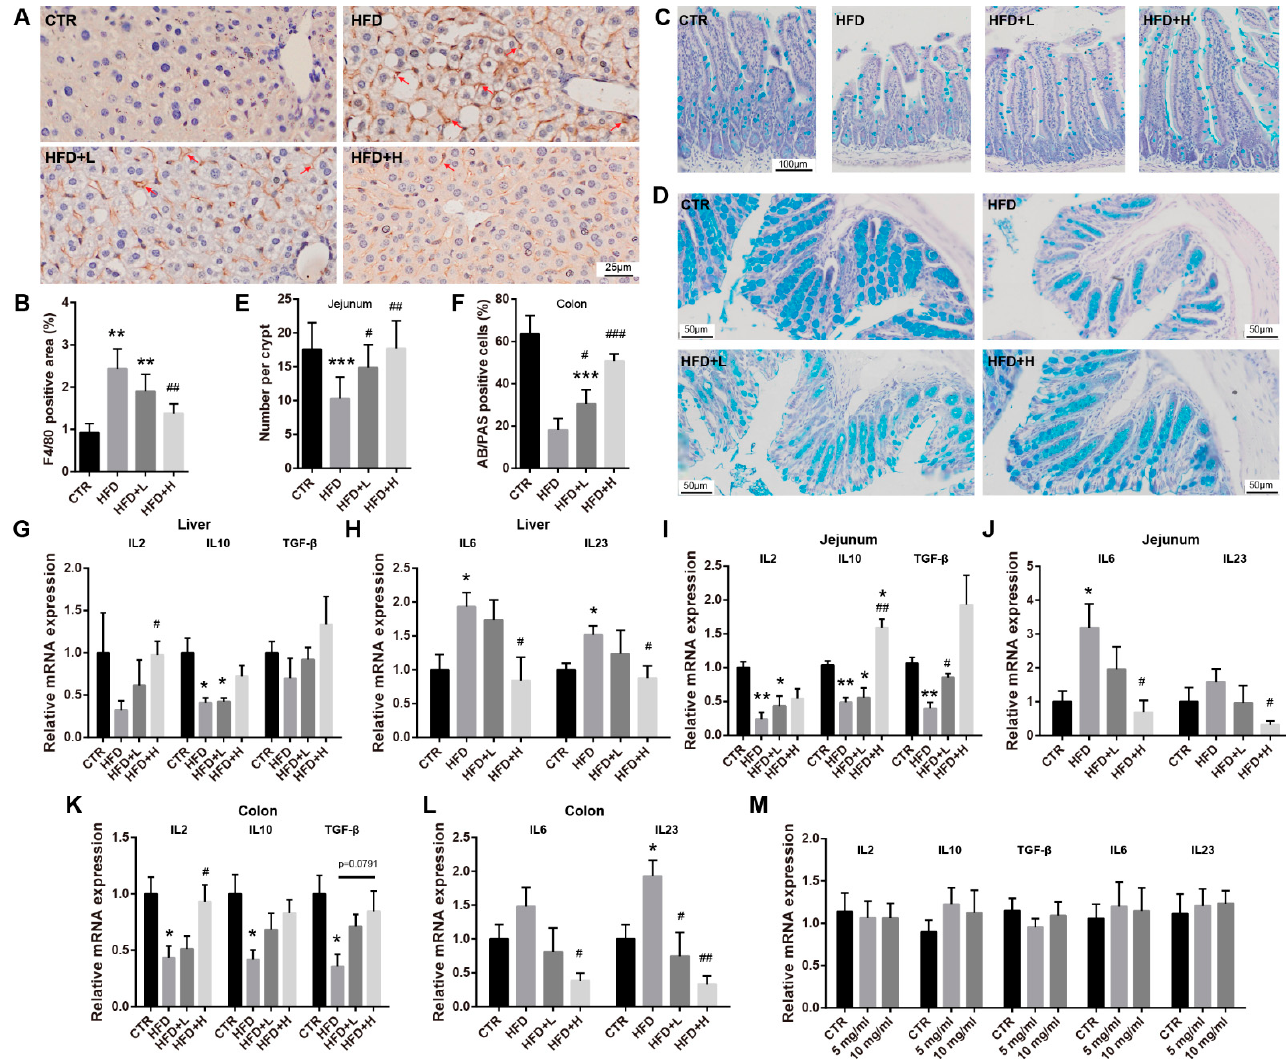
Figure 5. SMRR polysaccharide ameliorates inflammation in gut–liver axis induced by high-fat diet. ( A , B ) Representative images and quantification of F4/80 labeling in liver of each group of mice. Error bars indicate SEM; n = 4; ** or ## p < 0.0 by one-way ANOVA. Arrows indicate F4/80 positive signals; “*” stands for CTR vs. HFD, “#” stands for HFD vs. HFD+H. ( C – F ) Representative images of AB-PAS staining and quantifications showing goblet cells in jejunum ( C ) and colon ( D ) of mice from different groups. Error bars indicate SD; n = 5; * or # p < 0.05, ## p < 0.01, *** or ### p < 0.001 by one-way ANOVA. ( G – L ) qRT-PCR results showing the expressions of anti-inflammatory genes (IL2, IL10 and TGF- β ) and pro-inflammatory genes (IL-6 and IL23) in the liver, jejunum and colon of mice from different groups; n = 3; * or # p < 0.05, ** or ## p < 0.01, *** or ### p < 0.001 by one-way ANOVA. ( M ) qRT-PCR showing no effects of SMRR polysaccharide on the expressions of anti- or pro-inflammatory genes in JPEC-J2 cells; n = 4.